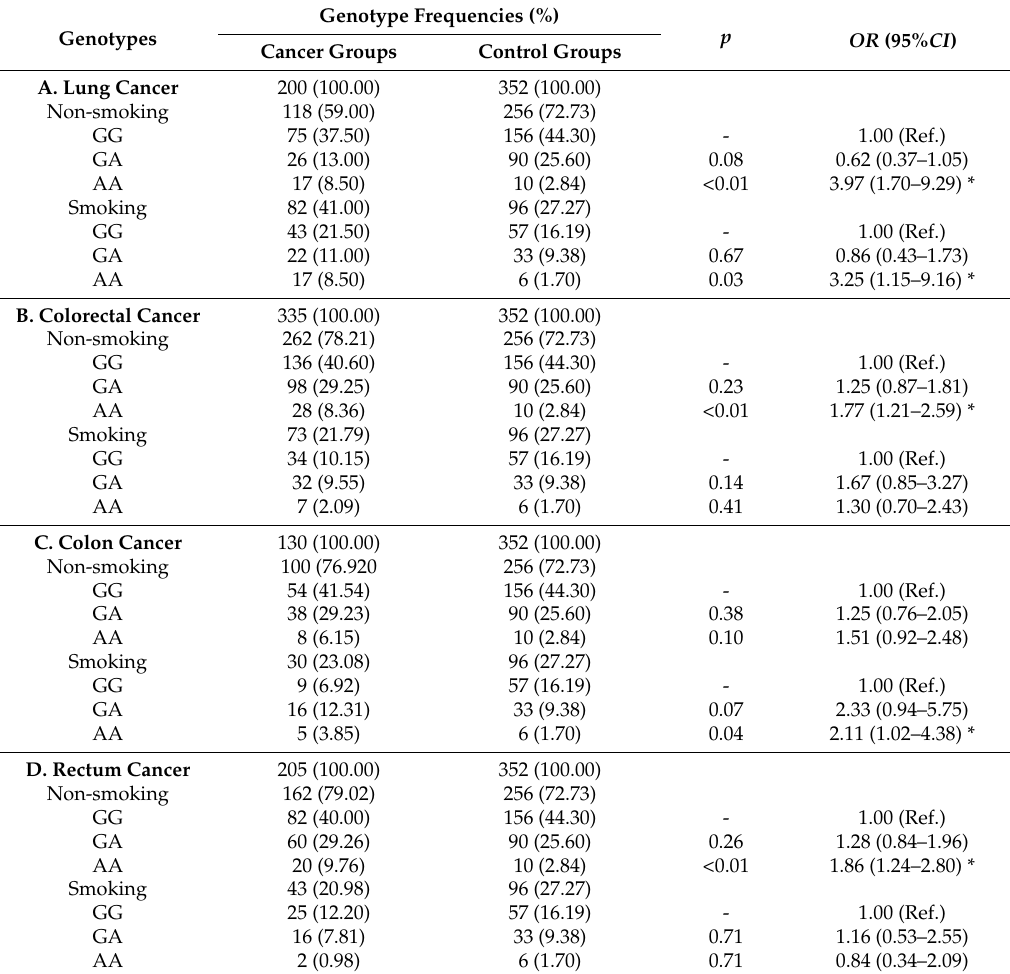
Table 7. Analysis for smoking status difference (non-smoking and smoking) in LOX G473A genotype frequency